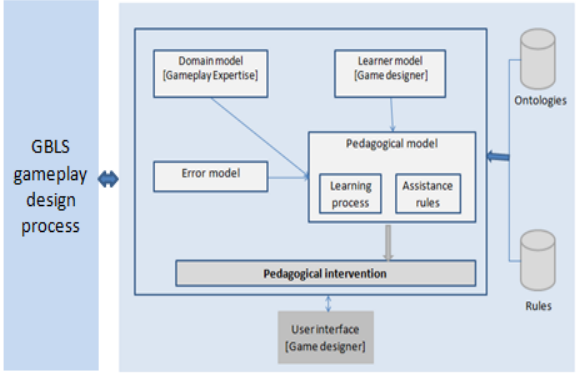
Figure 1. An overview of our framework main